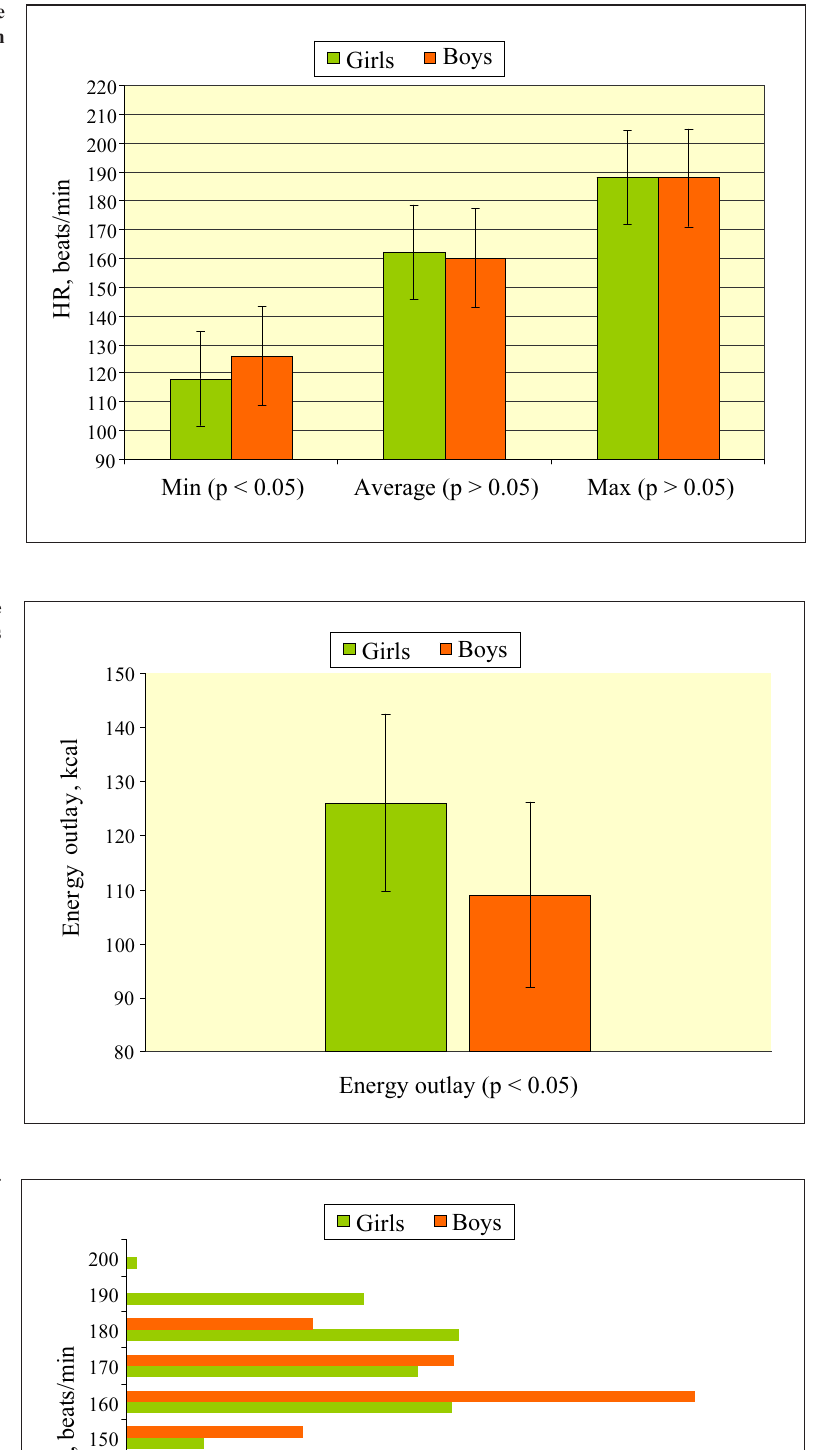
Figure 5. Energy outlay (kcal) for juvenile sports dancers in Latin American dances in